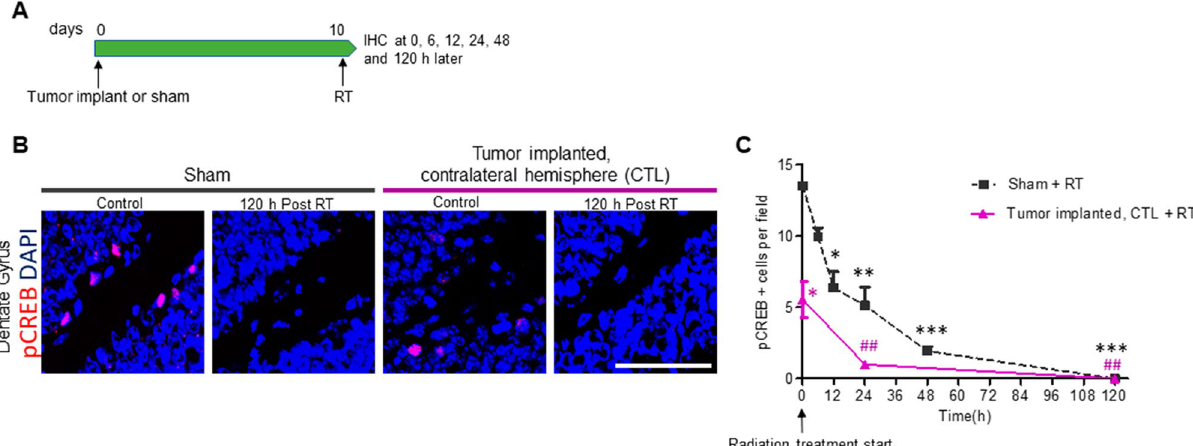
Figure 1. Radiation induced acute damage of neuroblasts in the subgranular zone (SGZ). ( A ) intracranial GL261 tumor implantation or sham operation was performed in C57BL/6 mice followed by 10 Gy cranial irradiation (RT) at 10 dpi. Mice were euthanized at 0, 6, 12, 24, 48 and 120 h after RT and brain samples processed for IHC. ( B ) Representative images of pCREB immunostaining at 0 (control) and 120 h after RT in sham and tumor implanted mice. Images were taken from the dentate gyrus (DG) of the hippocampus in the hemisphere contralateral (CTL) to the tumor implant site. Scale bar = 50 µm. ( C ) Quantification of pCREB positive cells in the SGZ at 0, 6, 12, 24, 48 and 120 h after RT. n = 3 per time point, * P < 0.05, ** P < 0.01 and *** P < 0.001 compared to sham control and ## P < 0.01 compared to tumor implanted control mice by repeated ANOVA followed by Tukey’s post hoc t